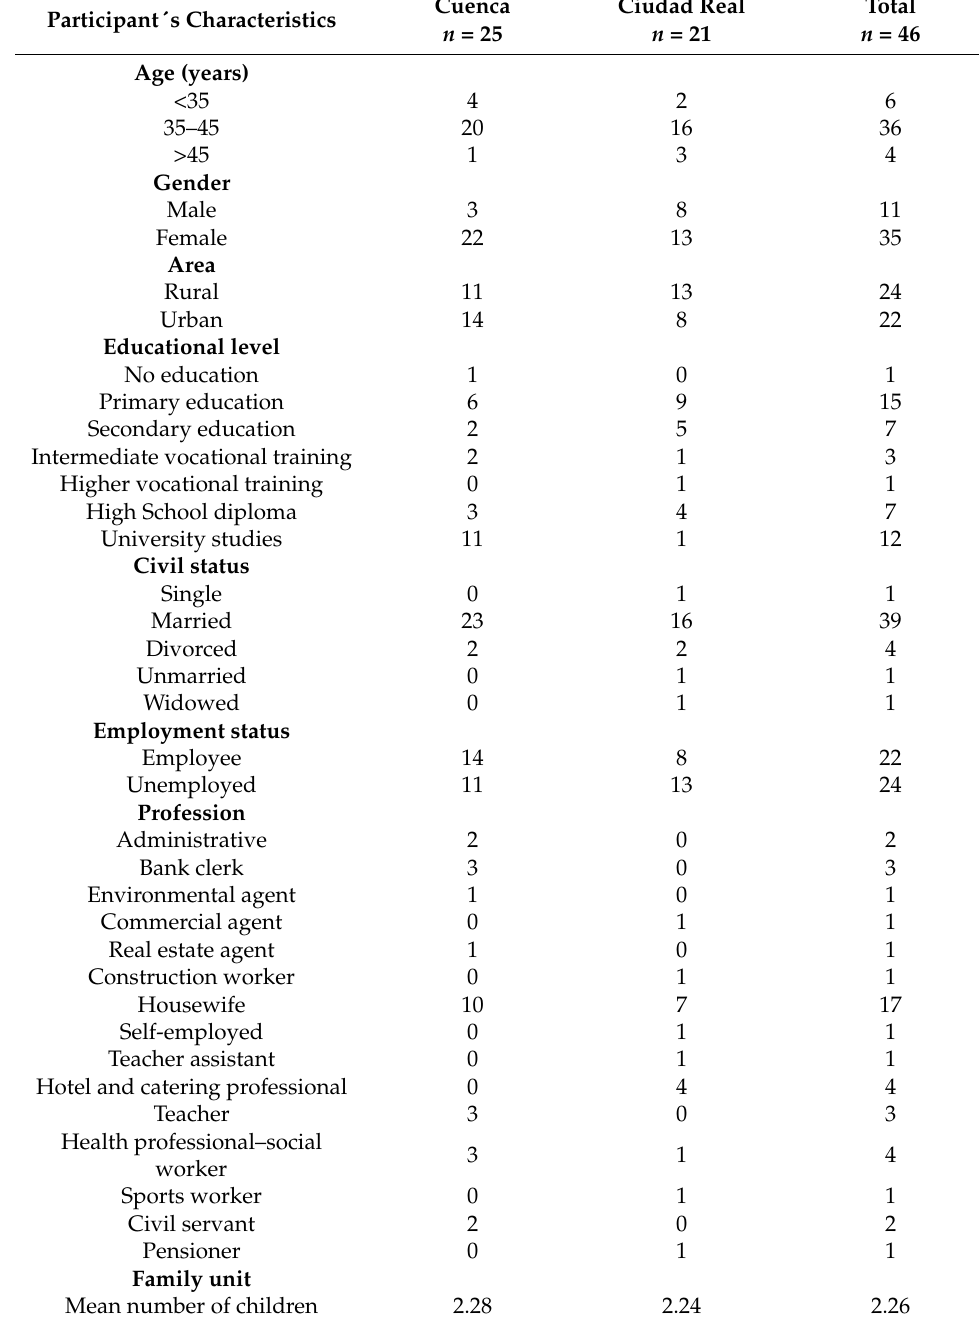
Table 2. Socio-demographic characteristics of the participants in the